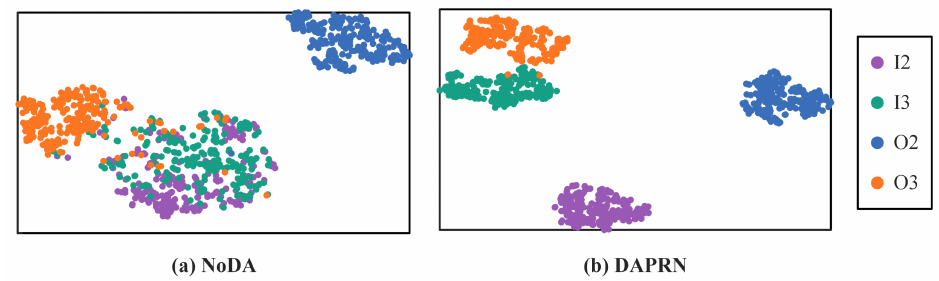
Figure 13. The visualization of target representation space.